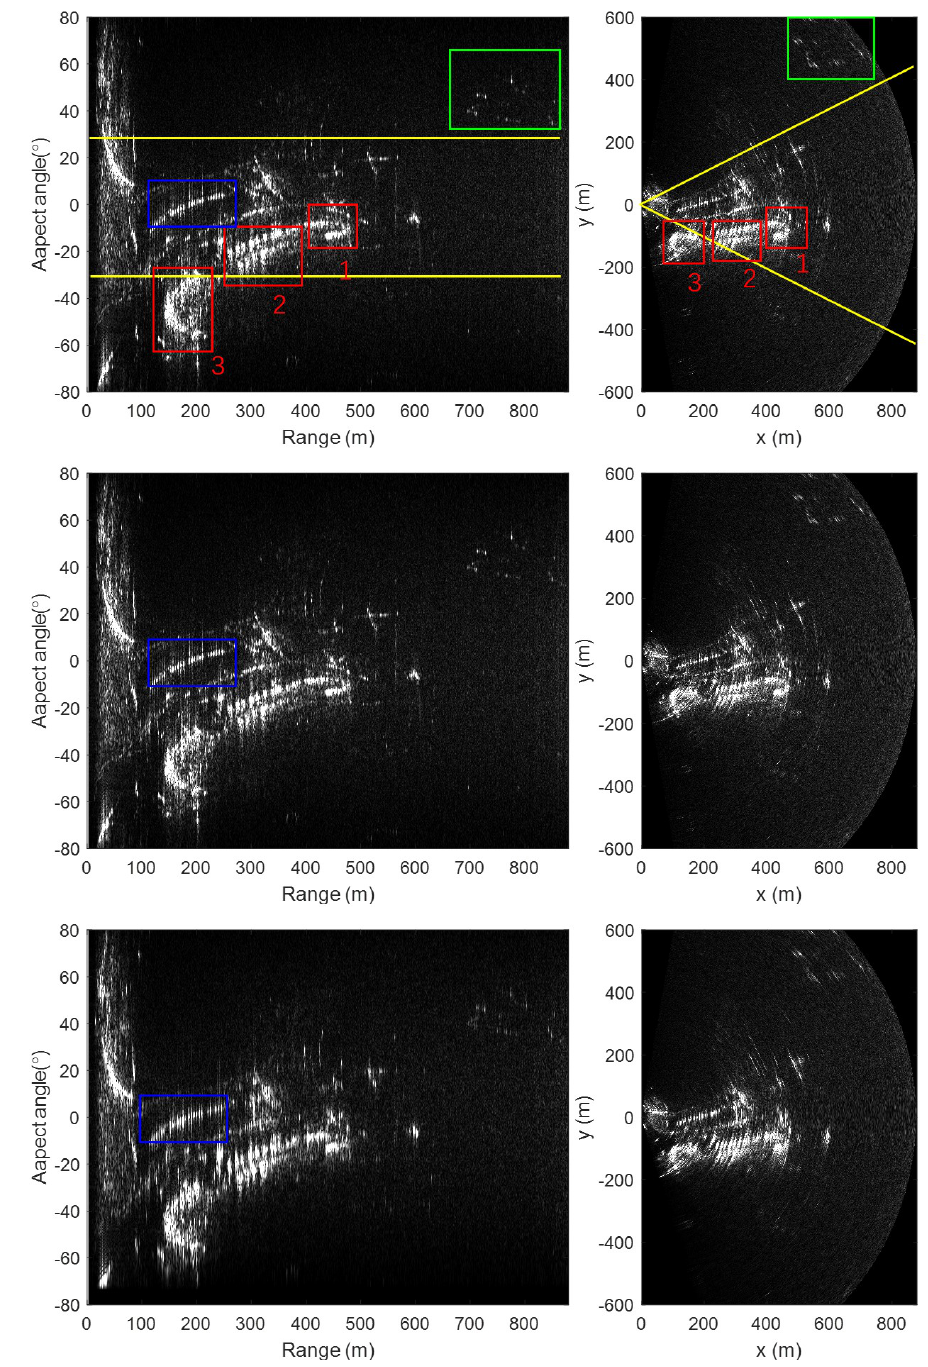
Figure 12. Real data imaging results: ( Up row ), Results with BP. ( Middle row ), Results with our method. ( Bottom row ), Results with Lee’s method. ( Left column ), Image in polar coordinates. ( Right column ), Image in Cartesian